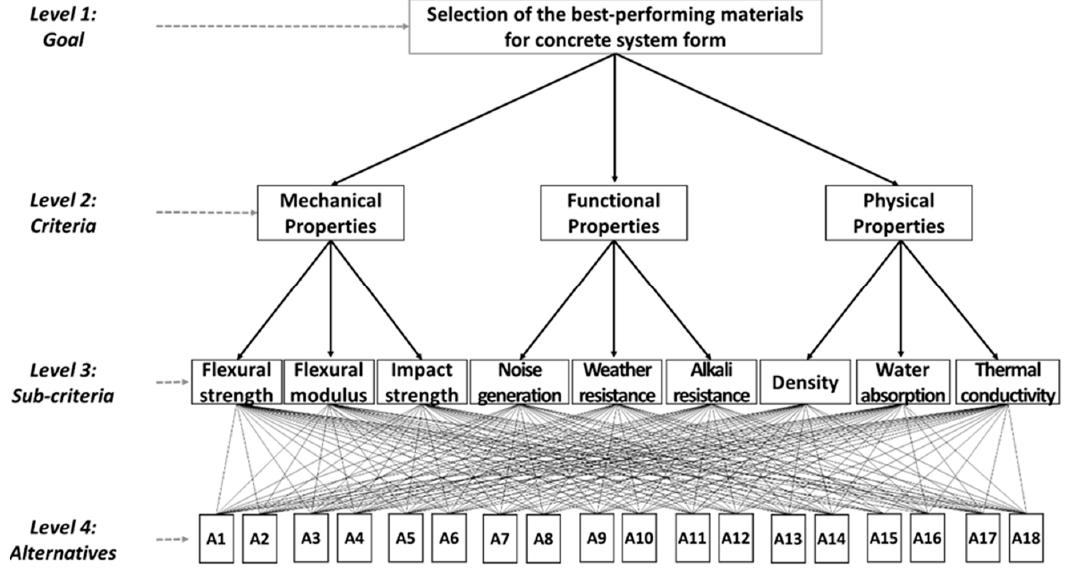
Figure 4. Hierarchical diagram for material selection criteria for concrete form.